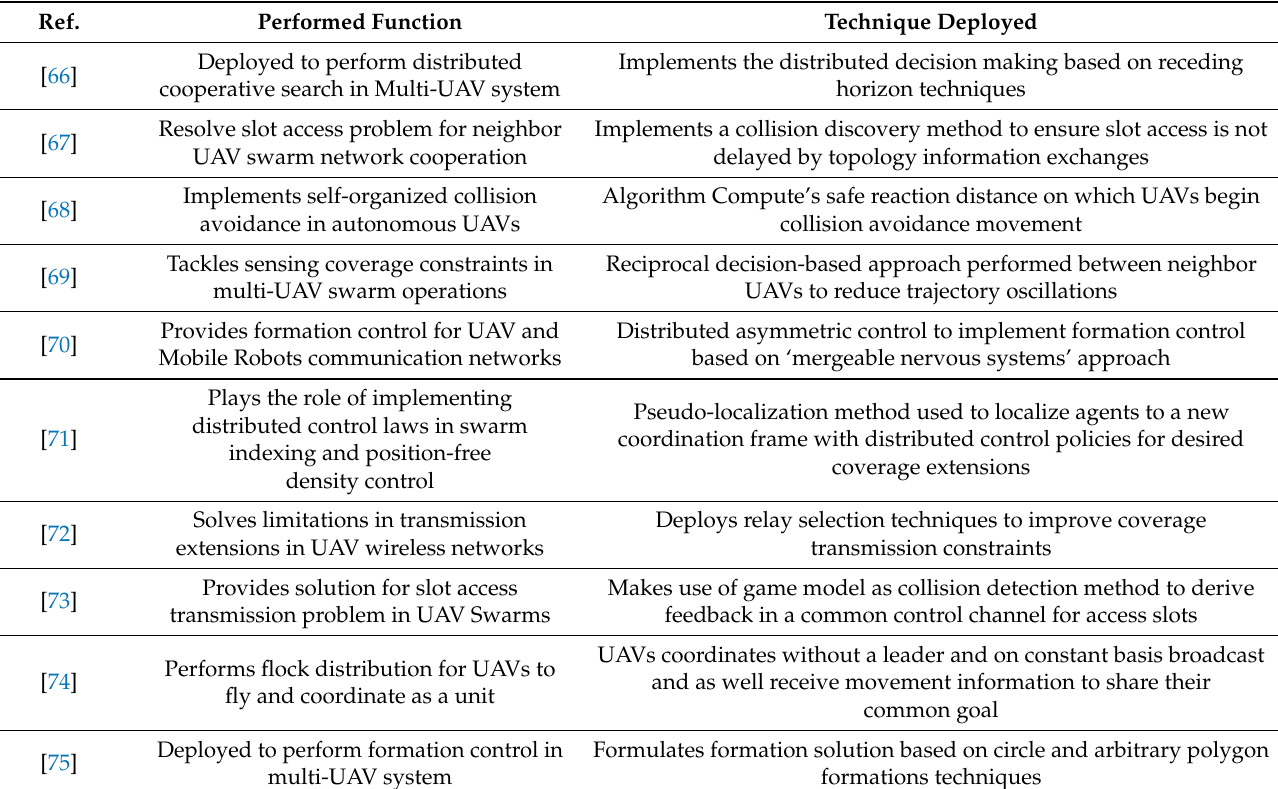
Table 2. Self-Organizing distributed